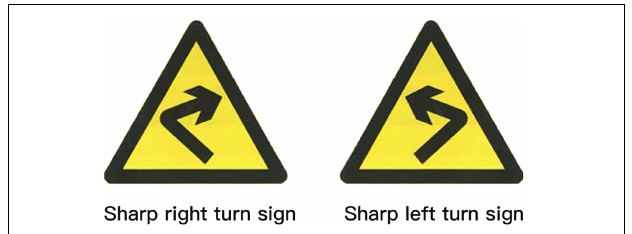
FIGURE 2 | Screening criteria: the same meaning but opposite direction of the sign to choose one, such as sharp left turn and sharp right